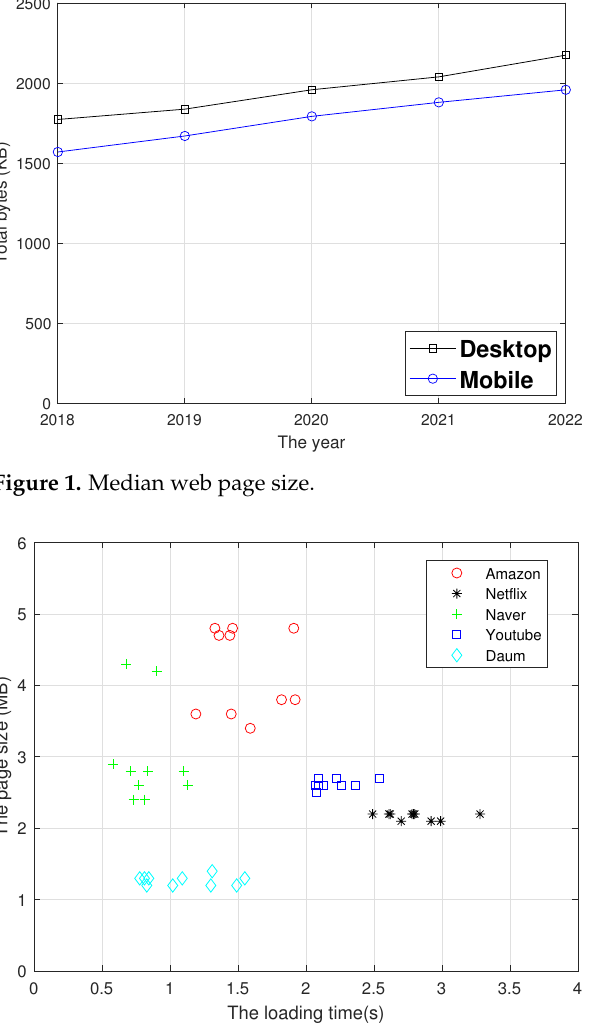
Figure 2. Loading time and size of web